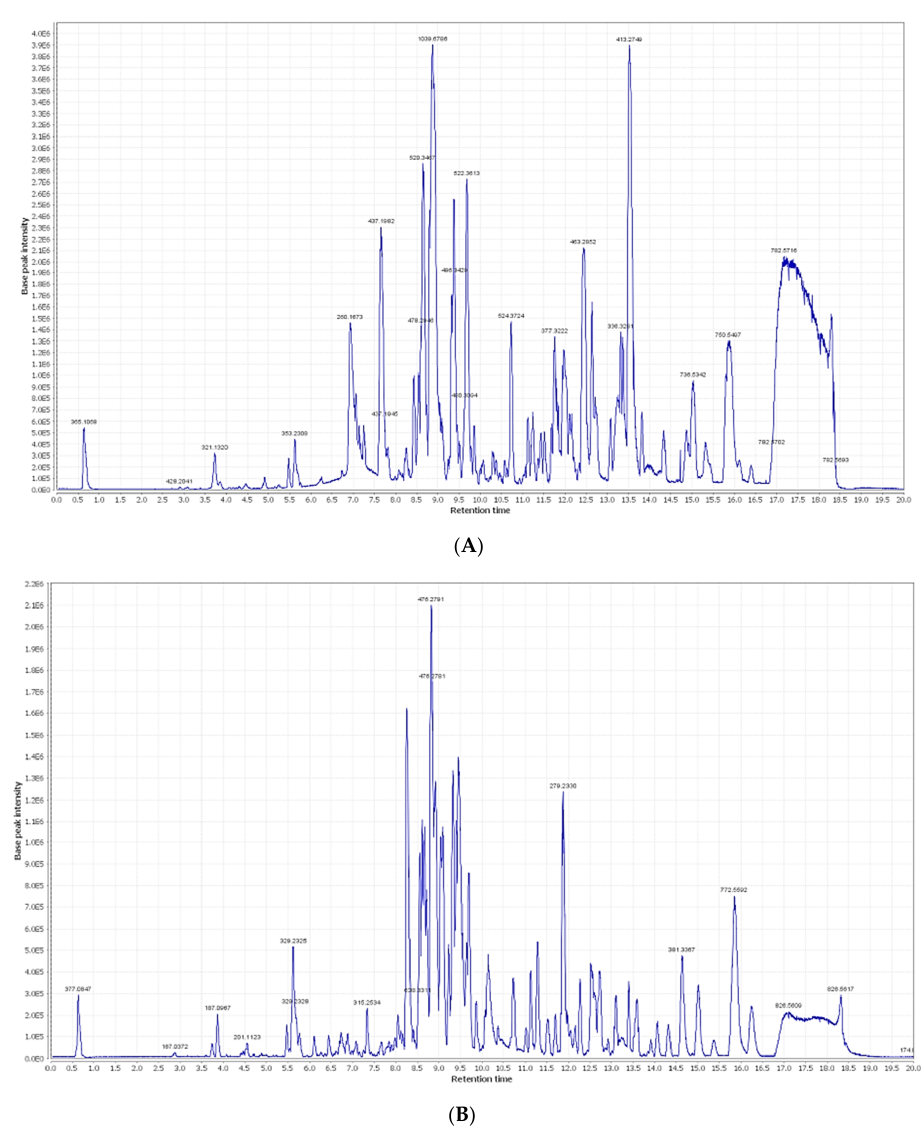
Figure 1. ( A ) LC-HRESIMS chromatogram of the dereplicated metabolites of Olea europaea L. cv. Picual (positive); ( B ) LC-HRESIMS chromatogram of the dereplicated metabolites of Olea europaea L. cv. Picual (negative).